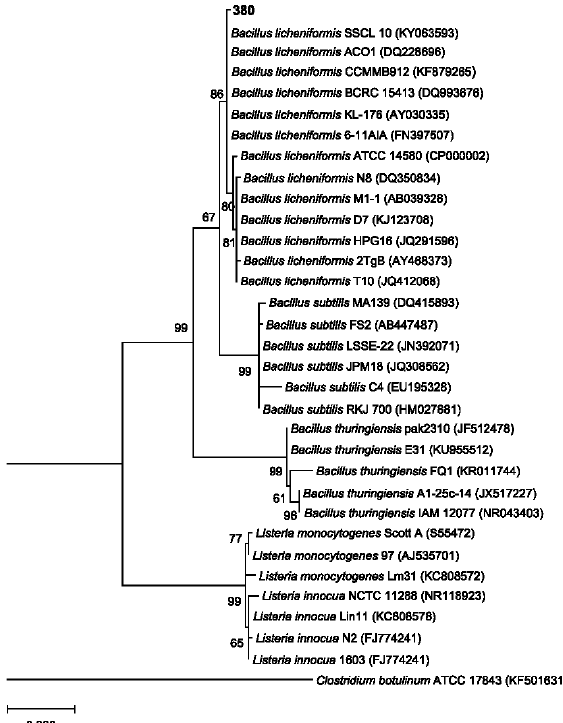
Figure 3 - The molecular weight of crude extract and purified CMCase in SDS-PAGE gel. Staining with Commasie Blue. M: Marker of 20-220 kDa range. CE- crude extract; PE- purified enzyme.